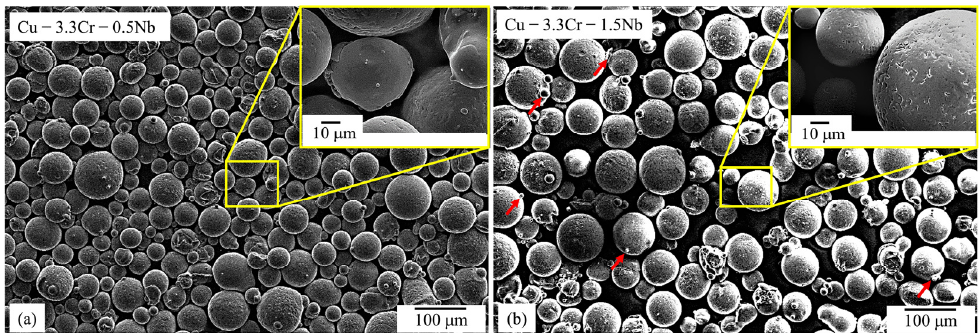
Figure 2. SEM images (SE mode) of gas-atomized powder particles with superimposed SEM image with higher magnification: ( a ) Cu-3.3Cr-0.5Nb alloy. ( b ) Cu-3.3Cr-1.5Nb alloy.